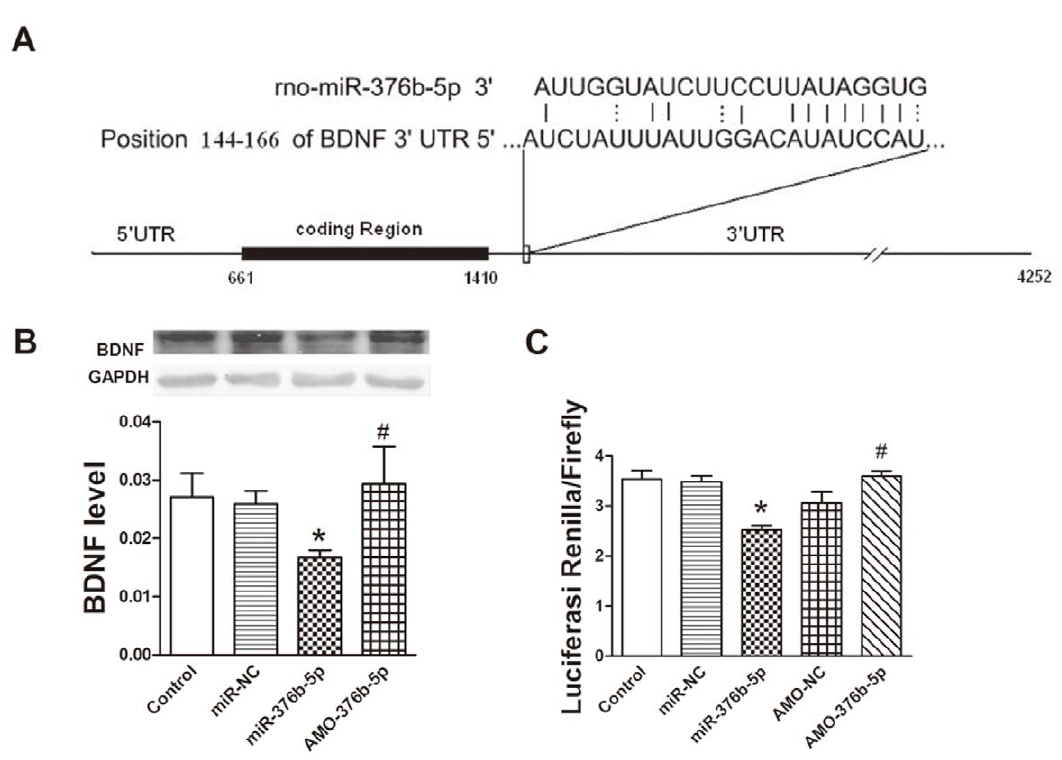
Figure 4. BDNF is a target gene of miR-376b-5p in cardiac myocytes. (A) MiR-376b-5p binding site in 3 9 -untranslated region (3 9 -UTR) of BDNF gene. (B) Inhibitory effects of miR-376b-5p on BDNF expression at the protein level. BDNF level was determined by Western blot after H9c2 cells were transfected with miR-376b-5p negative control (miR-NC), miR-376b-5p and 2 9 -O-methyl-modified antisense oligoribonucleotides of miR-376b-5p (AMO-376b-5p, miR-376b-5p inhibitor) for 24 h. GAPDH served as loading control. Top, representative Western blots; bottom, quantitation as mean 6 SEM. Note: n=3; * P , 0.05 vs. miR-NC, # P , 0.05 vs. miR-376b-5p. (C) Luciferase assay for direct inhibitory effects of miR-376b-5p on BDNF expression. The reporter construct was transfected into HEK 293T cells with miR-NC, miR-376b-5p, AMO-376b-5p or AMO-376b-5p negative control (AMO-NC). Luciferase activity was normalized by Firefly luciferase signal in HEK 293T cells. Following transfection for 24 h, luciferase activities were measured on a luminometer. Values were expressed as mean 6 SEM; n=3; * P , 0.05 vs. miR-NC, # P , 0.05 vs.